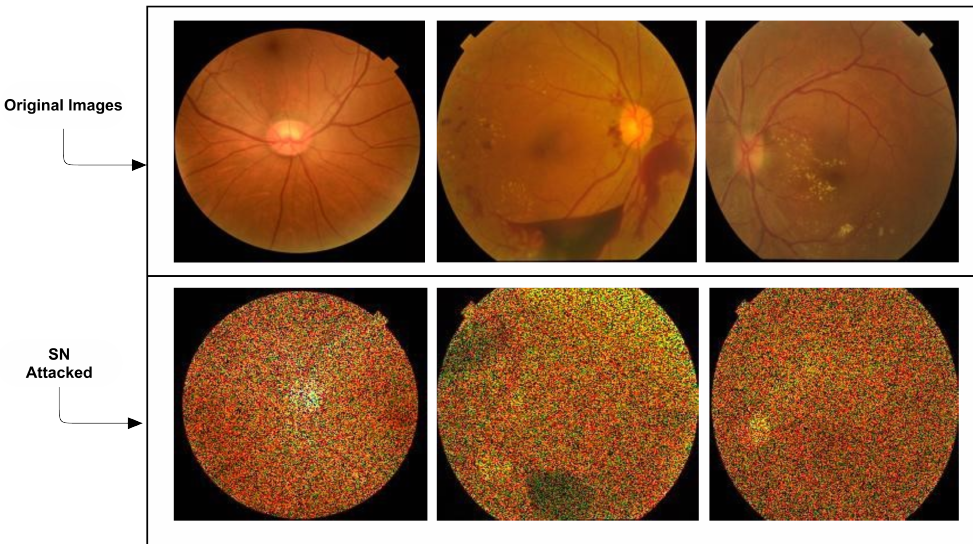
Figure 3. Addition of FGSM attacks. The first row shows the original images, while the second row represents the SN attacked